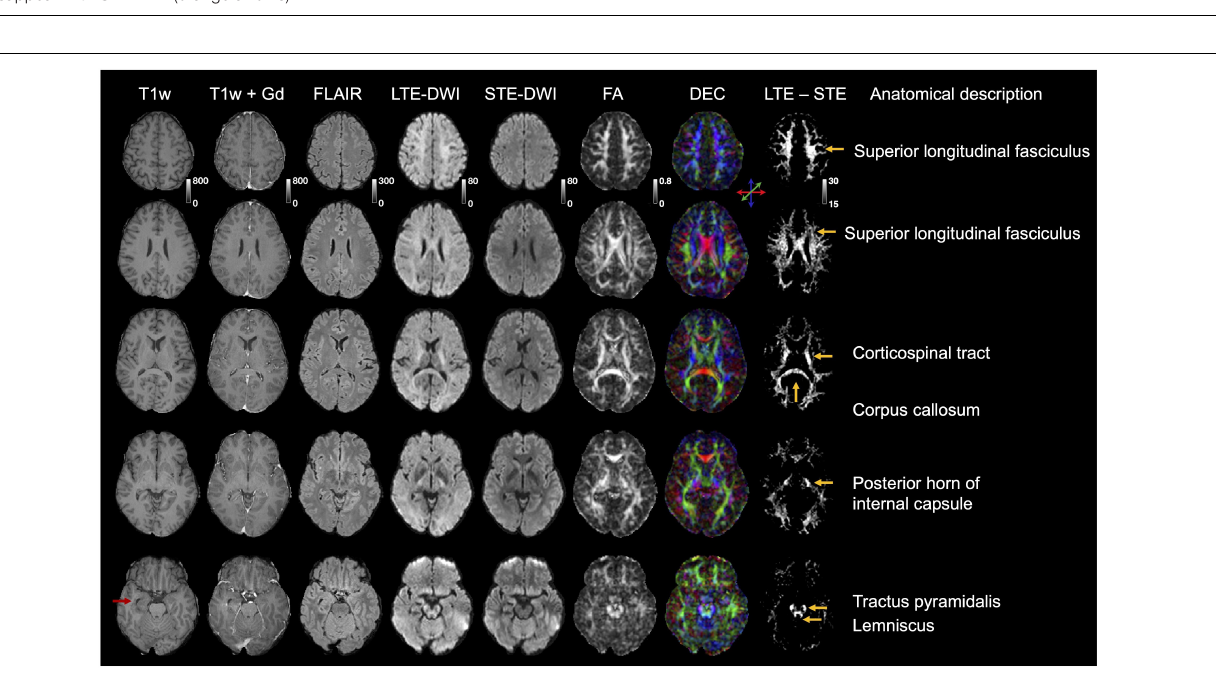
Frontiers in Neuroscience |